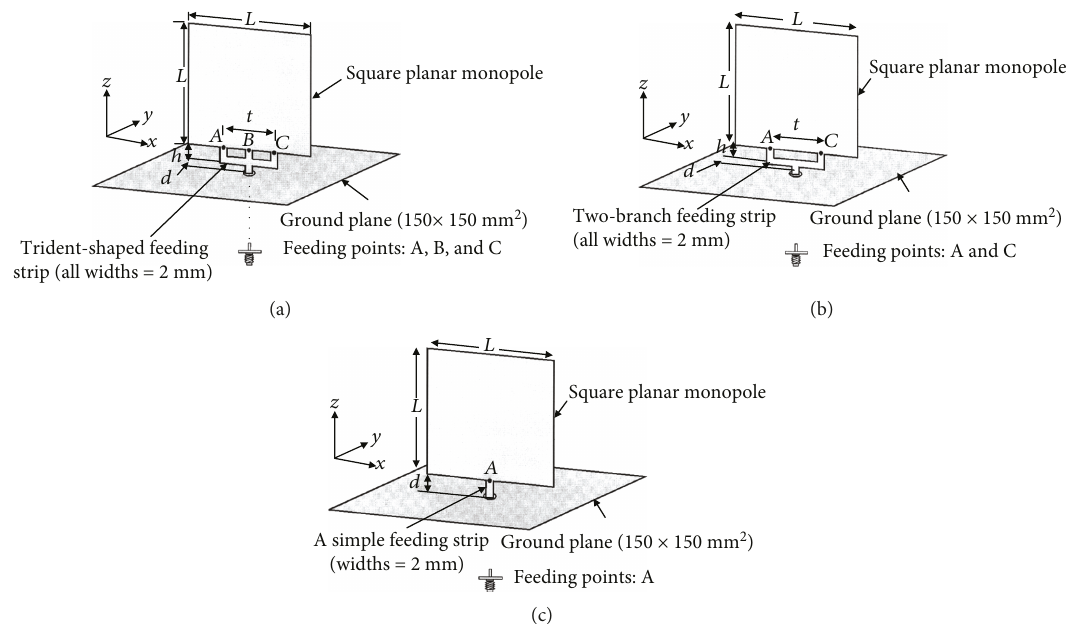
Figure 9: A trident-shaped antenna mounted on a square metal plate